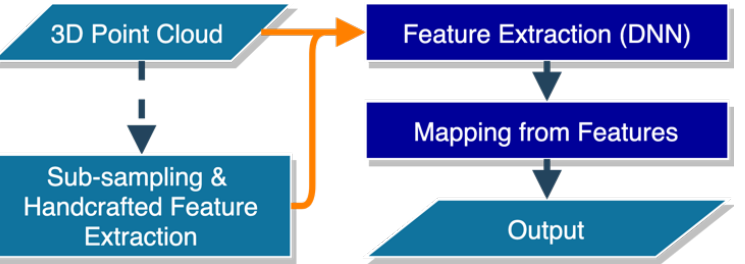
Figure 2. The proposed classification framework based on deep learning (modules that can learn from the given data are shown with dark blue